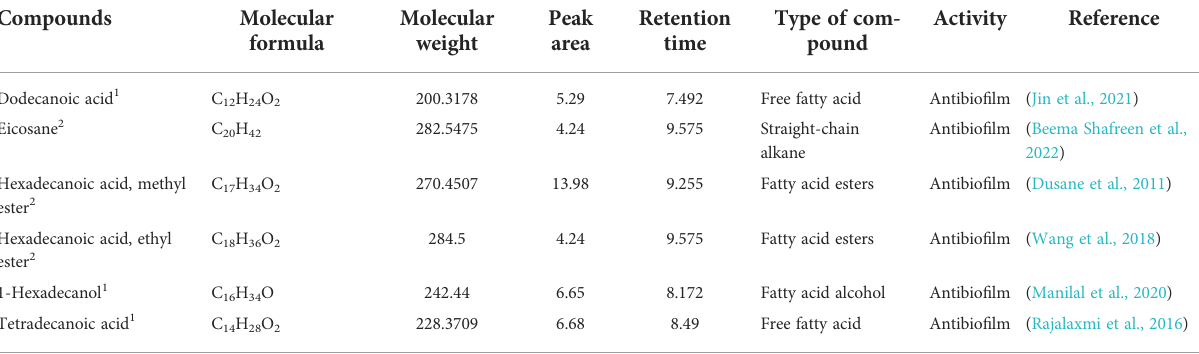
TABLE 3 Antibio fi lm compounds detected from Alcanivorax sp. AA8